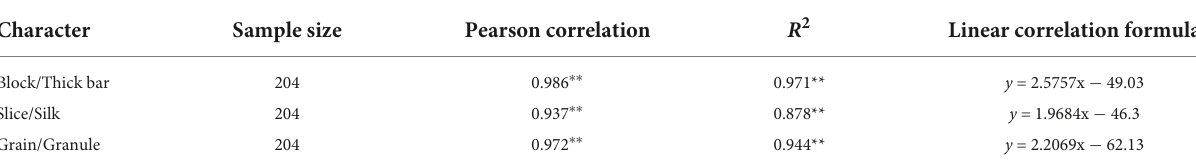
TABLE 4 Food image area-actual food weight relationship model.